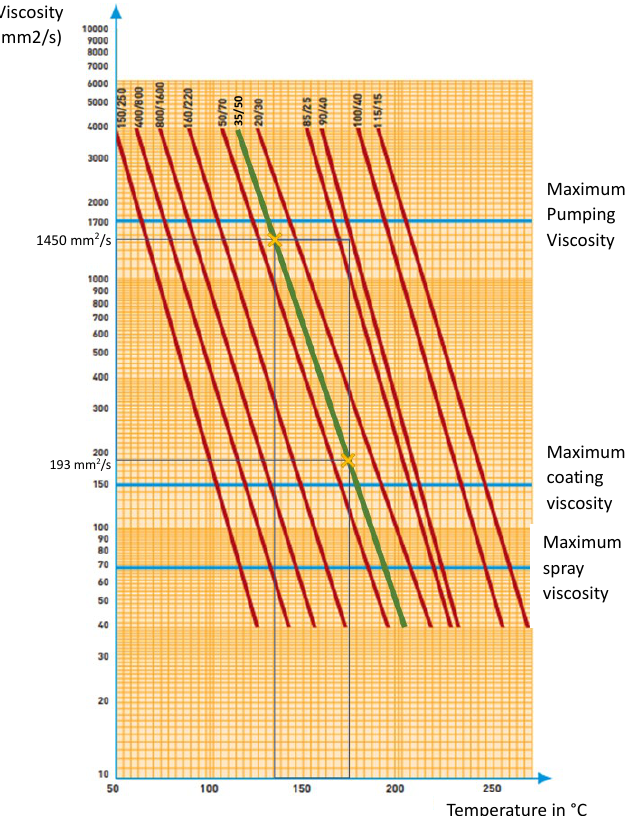
Figure 6. Bitumen viscosity variation as a function of temperature [38].